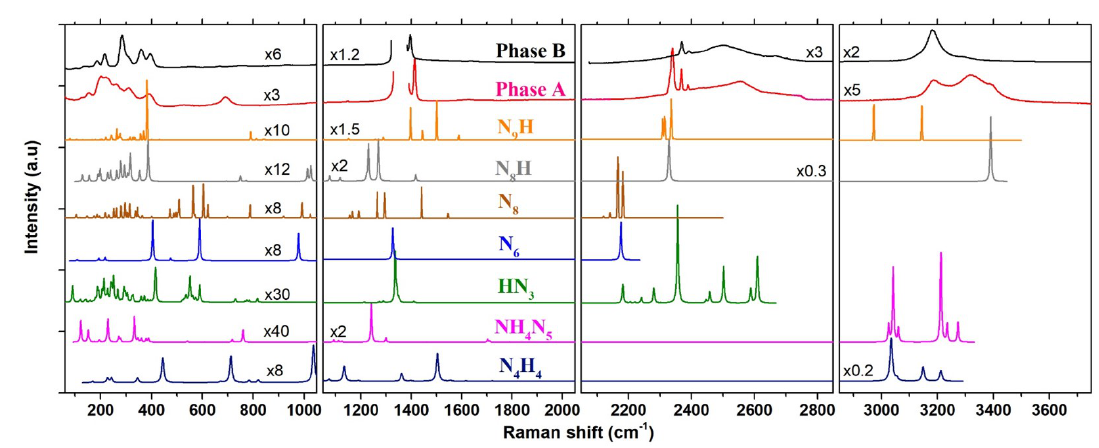
Figure 6. Comparison between the experimental Raman spectra of phases A and B at 20.5 GPa–300